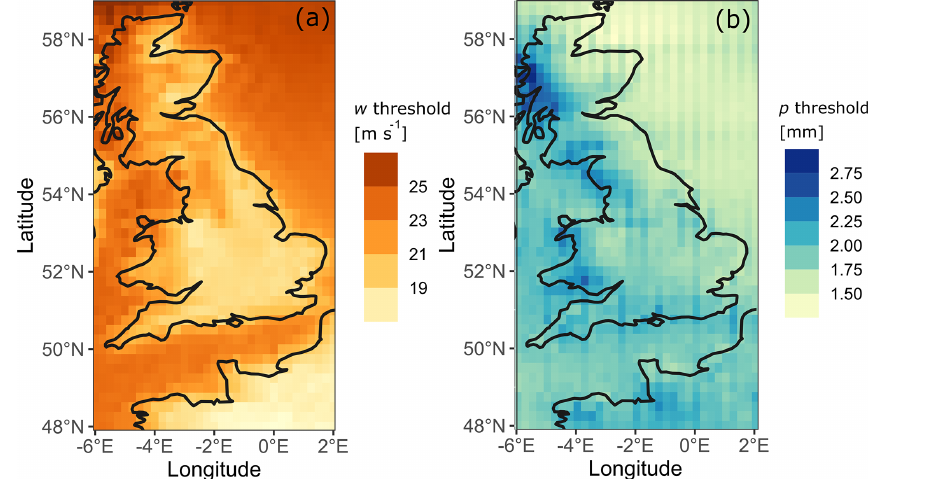
Figure 5. Threshold values (see legends) used to extract extreme values for the clustering process over Great Britain and northwestern France. The values correspond to the 99th percentile on each grid cell during the period 1979–2019 for (a) hourly maximum wind gust ( w ) and (b) hourly precipitation accumulation ( p ). Data from ERA5 (Hersbach et al.,